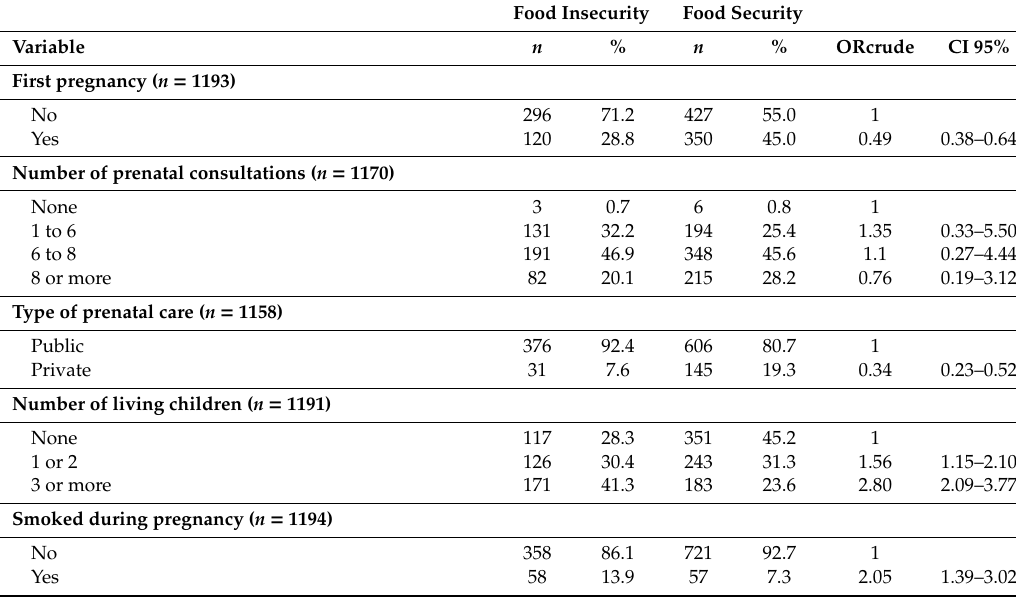
Table 3. Food insecurity in gestation according to prenatal care and gestational habits. Rio Branco, Acre,